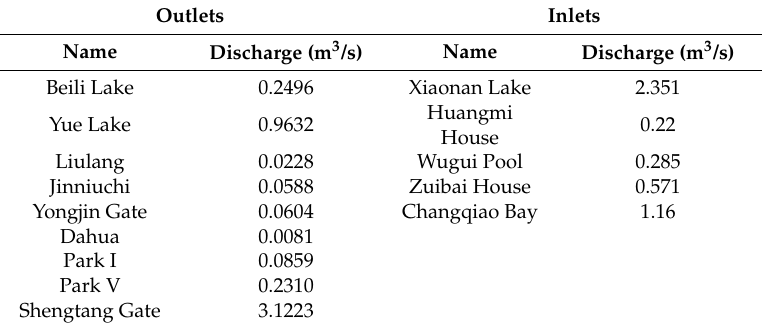
Table 1. Discharge at the five inlets and nine outlets.